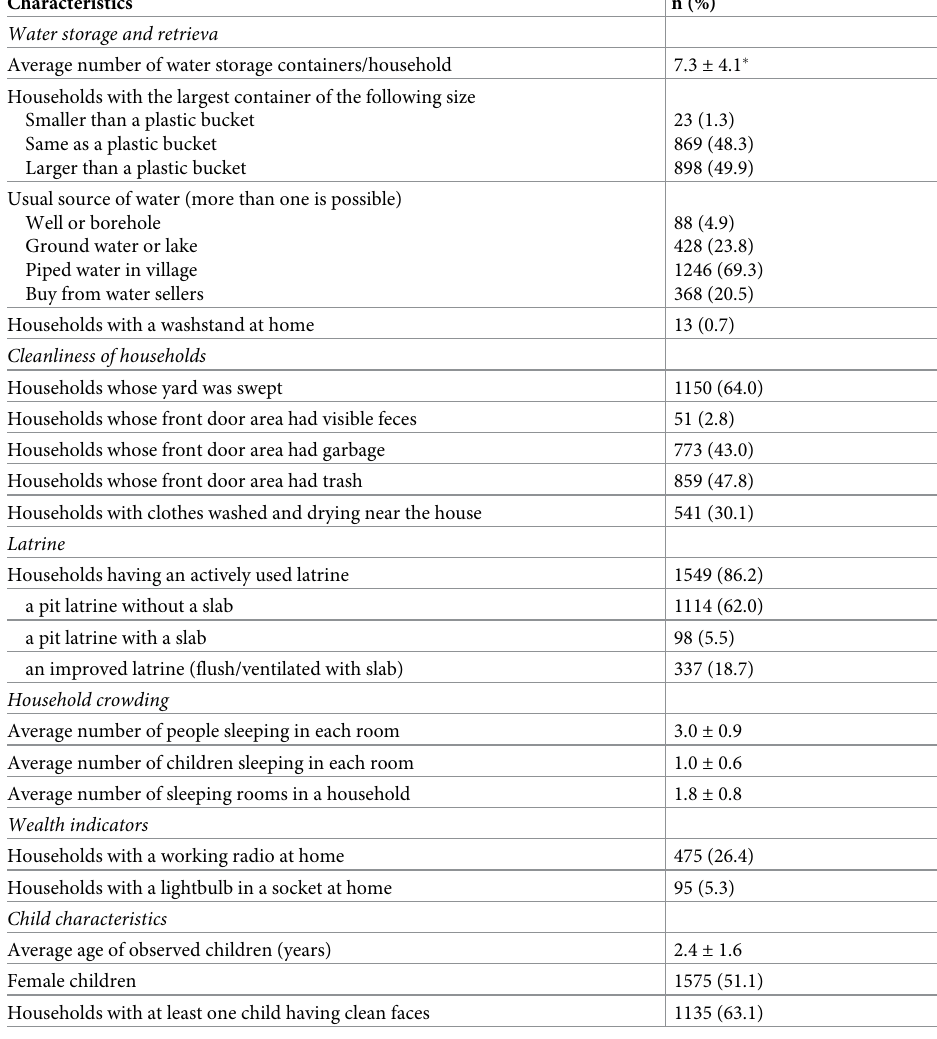
Table 1. Characteristics of households (N = 1798) and children (N = 3084) in Kongwa survey in all 92 villages. Characteristics n (%) Water storage and